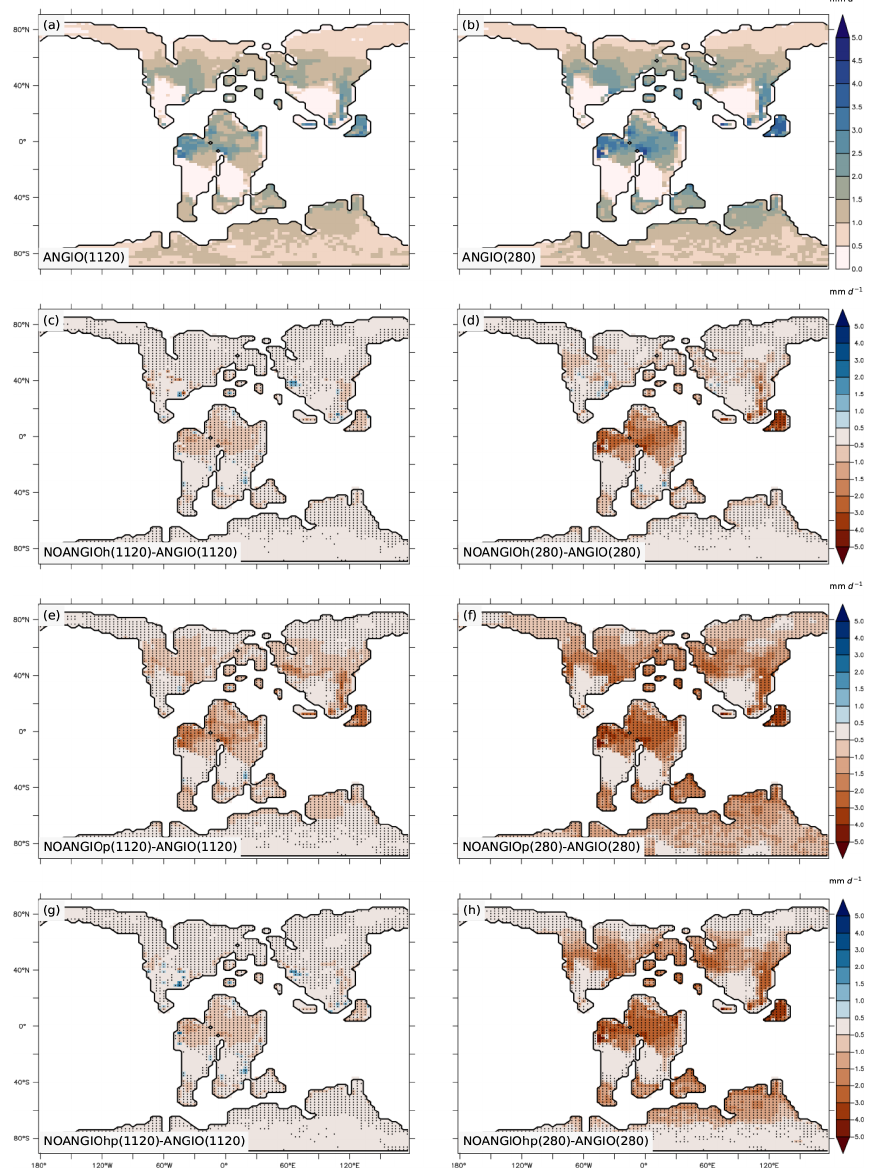
Figure 7. Annual mean transpiration rate (mmd − 1 ) for (a) ANGIO(1120) and (b) ANGIO(280), anomalies of annual mean transpiration rate (mmd − 1 ) for (c) NOANGIOh(1120) vs. ANGIO(1120), (d) NOANGIOh(280) vs. ANGIO(280), (e) NOANGIOp(1120) vs. ANGIO(1120), (f) NOANGIOp(280) vs ANGIO(280), (g) NOANGIOhp(1120) vs. ANGIO(1120) and (h) NOANGIOhp(280) vs. ANGIO(280). The t -test 95% confidence level anomalies are given by